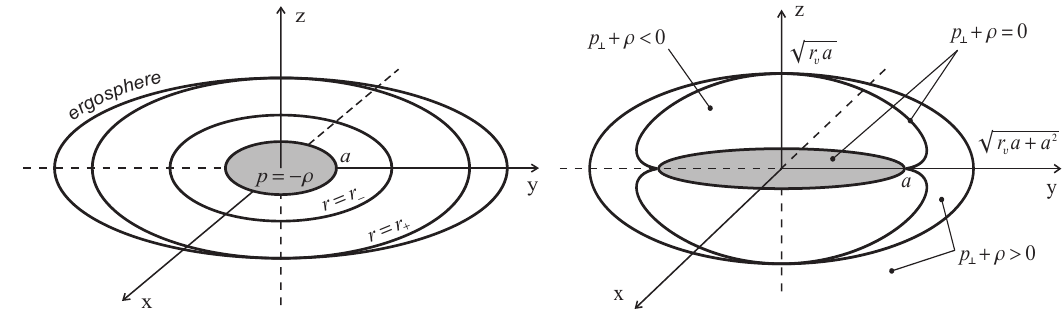
Figure 1. Left : Horizons, ergosphere, and the interior de Sitter vacuum disk for a de Sitter-Kerr black hole with the first type of interior. Right : Vacuum S -surface p ⊥ + ε = 0 for the de Sitter-Kerr black hole with the second type of interior. In Figure 1 energy density is denoted by ρ ( ε = ρ in the units c = G =